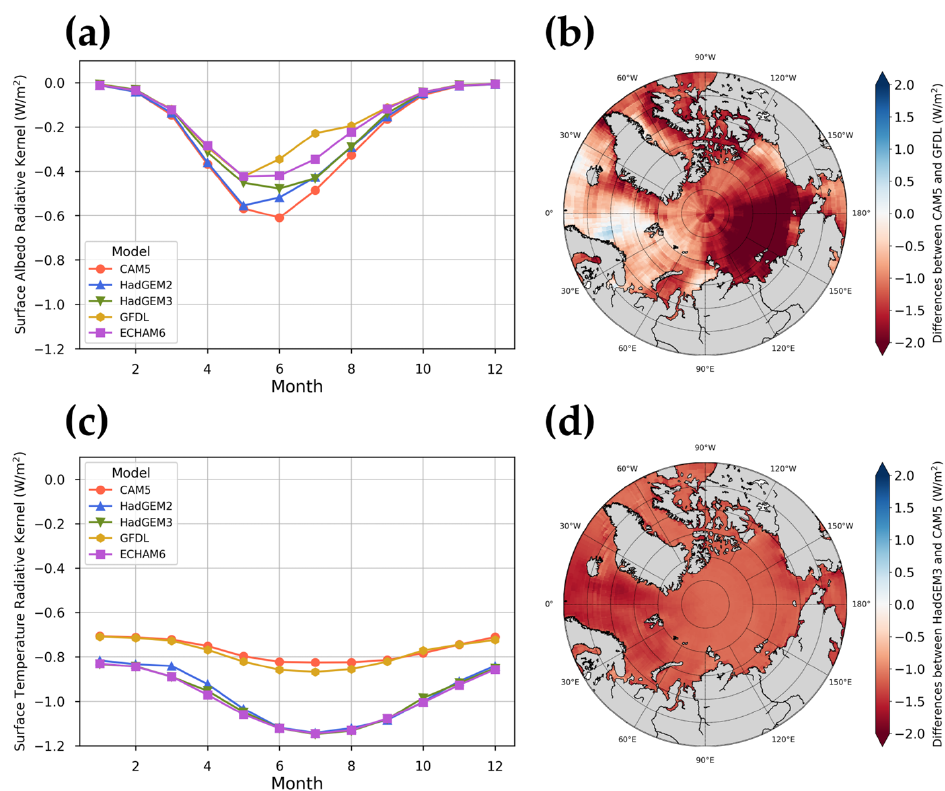
Figure 2. Distribution of radiative kernels in the Arctic. ( a ) Temporal distribution of surface albedo radiative kernel (all-sky) monthly means according to GCM. ( b ) The spatial distribution of the difference between CAM5 and GFDL surface albedo radiative kernel. ( c ) Temporal distribution of surface temperature radiative kernel (all-sky) monthly means according to GCM. ( d ) The spatial distribution of the difference between HadGEM3 and CAM5 surface temperature radiative kernel.